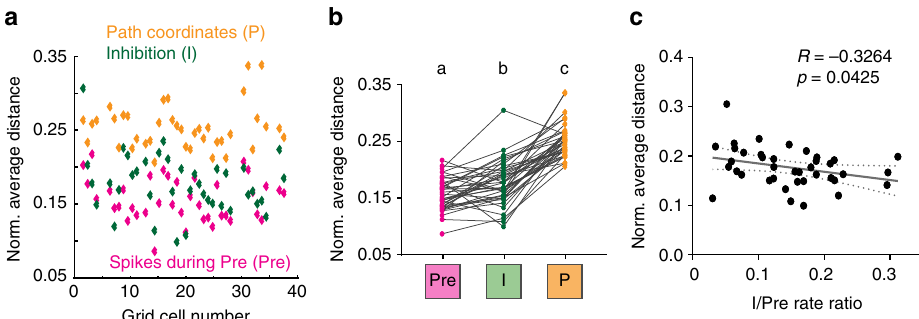
Fig. 9 Grid cell spikes during inhibition occurred farther from the grid center. a The average distance of each I spike (green dots) from the center of the